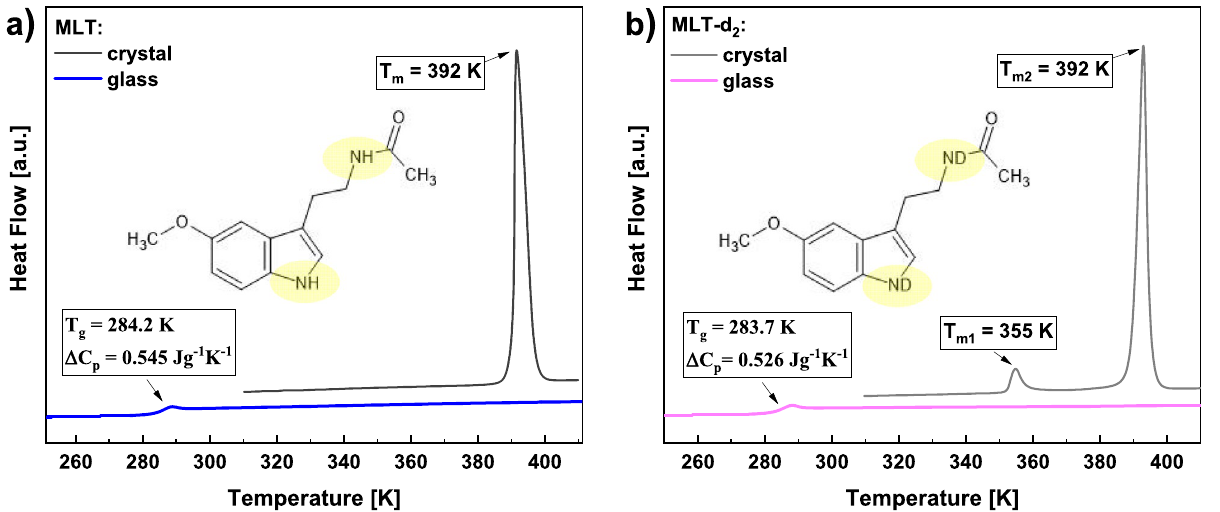
Figure 2. DSC thermograms obtained during heating of the crystalline and glassy MLT ( a ) and MLT-d 2 ( b ) with the rate of 10 K/min. In the insets, the chemical structures of both substances are The representative FTIR spectra of MLT and MLT-d 2 , in the crystalline and supercooled liquid phases are pre- sented in Fig. 1, while the chemical structures of these compounds are shown in Fig. 2. According to early XRD studies, the molecules of the crystalline MLT are connected in sheets by N–H···O hydrogen bonds with a N···O distance of 2.90 and 2.96 Å 37,38 . Here, the H-bonding interactions are reflected in the IR spectrum of crystalline MLT as a strong band with a maximum at 3272 cm -1 assigned to the stretching vibrations of two N–H groups. In the 3100–2800 cm -1 region, the bands related to different C-H stretching vibrations occur. Based on the calculated potential energy distribution (PED), for the minimum energy conformer of MLT, absorption bands at 2828, 2873, 2928, 2948, and 2991 cm -1 are assigned to symmetric and antisymmetric C-H stretching motions 39 . A signal occurring at 3084 cm -1 corresponds to the aromatic C-H stretching vibrations. In the 1700–900 cm -1 frequency range, the peaks associated with various vibrational modes, such as C=O, C–C, and C–N stretching, C-H, and N–H bending, are generally observed. There is also a signal at 1624 cm -1 due to the C=O stretching. According to Ref. 39 , a band occurring at 1587 cm -1 is attributed to the asymmetric C=C stretching and in-plane C–C–C bending of the benzene ring, whereas a signal at 1552 cm -1 corresponds to mixed asymmetric C=C stretching of the benzene ring and the C=C stretching of the five-membered ring. A peak occurring at 1488 cm -1 is related to the asymmetric C-N stretching of the amide group, in-plane bending of C–N–H moiety, and C-H scissoring of the methylene unit. Moreover, the bands located at 1462 and 1424 cm -1 are ascribed to C-H scissoring vibrations, whereas a peak at 1370 cm -1 corresponds to C-H symmetric deformation. The bands due to C-H twisting motions are observed at 1310 and 1295 cm -1 , while those assigned to in-plane aromatic C-H bending vibrations occur at 1211 and 1136 cm -1 . There are also peaks at 1176 cm -1 and 1040 cm -1 , connected to C-O stretching vibrations and C-H rocking motion, respectively. As shown in Fig. 1a,b, the IR spectra for the crystalline and supercooled MLT are similar, although the IR peaks for the latter sample are wider and blurred (no band splitting) compared to those collected for the crystal- line API. This fact indicates a structural disordering in the supercooled MLT. In addition, the band at 3272 cm -1 attributed to the N–H stretching of amine groups is significantly broadened and gains an additional component with a frequency of 3398 cm -1 , which denotes a change of hydrogen bonding interactions and a re-organization of the H-bond pattern after transformation of the sample from the crystalline to the disordered state. For the crystalline MLT-d 2 , the peak from N–H vibrations at 3272 cm -1 is almost completely damped. On the other hand, the C-H bands for this compound exhibit nearly the same frequencies as for neat MLT. It indicates that the H/D exchange occurs only in N–H groups. As a result, the most significant changes in the spectral parameters are expected for the groups participating in the H-bond formation. Indeed, in the spectrum of MLT-d 2 , a new strong band at 2433 cm -1 assigned to the N–D stretching vibrations appears. From the integrated intensity ratio of the N–H to N-D bands, the degree of H/D substitution can be estimated. According to this method, the degree of H/D isotopic exchange is very high, > 99%, as almost no N–H absorption signal is observed in the 3500–3100 cm -1 frequency range. What is more, it was found that the partially-deuterated MLT exhibits extraordinary long-term stability since no reverse D/H exchange for over a dozen months of exposure to the air was noted. In addition, it is worth emphasizing that upon heating to the melting temperature and vitrification, only a slight loss of deuterons (~ 15%) was observed via D/H back-exchange with H atoms coming from the air. Thus, we demonstrated that it is possible to effectively convert MLT-d 2 from the crystalline to the glassy state, without a significant loss of D atoms, by the vitrification of the molten system. In the low-frequency spectral range, the bands at 1552, 1370, 1325, 1295, 1103, and 1000 cm -1 , which were observed for neat crystalline MLT, disappeared for its deuterated derivative. On the other hand, a new peak of weaker intensity arose at 967 cm -1 . Moreover, some of the bands for crystalline MLT-d 2 in the range 1800–950 cm -1 were slightly shifted in relation to the corresponding peaks for MLT. The IR spectrum for super- cooled MLT-d 2 exhibited similar behavior as for the crystalline sample, i.e., the new band at 2457 cm -1 appeared